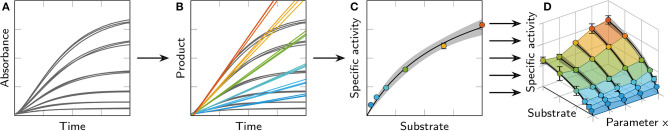
Overview of the data processing steps used for the evaluation of activity assays with polyHIPE cylinders. The example shows data from the analysis of different aqueous phase volume fractions. (A) The product formation was monitored by measuring the absorbance at 460 nm in a spectrophotometer. The curves show triplicates of six different substrate concentrations. (B) Using calibration curves, the product concentration was calculated from the absorbance signal and the maximum slope of the resulting curves was calculated to determine the maximum volumetric activity. Due to diffusion limitations, the maximum slope does not occur at the start of the reaction but after an initial delay time tdelay. (C) The specific activity was calculated from the volumetric activity and the resulting data points were plotted over the substrate concentration and fitted with a Michaelis-Menten equation (95% confidence intervals shown in gray). (D) Several kinetics curves were combined with a surface plot to compare different conditions.